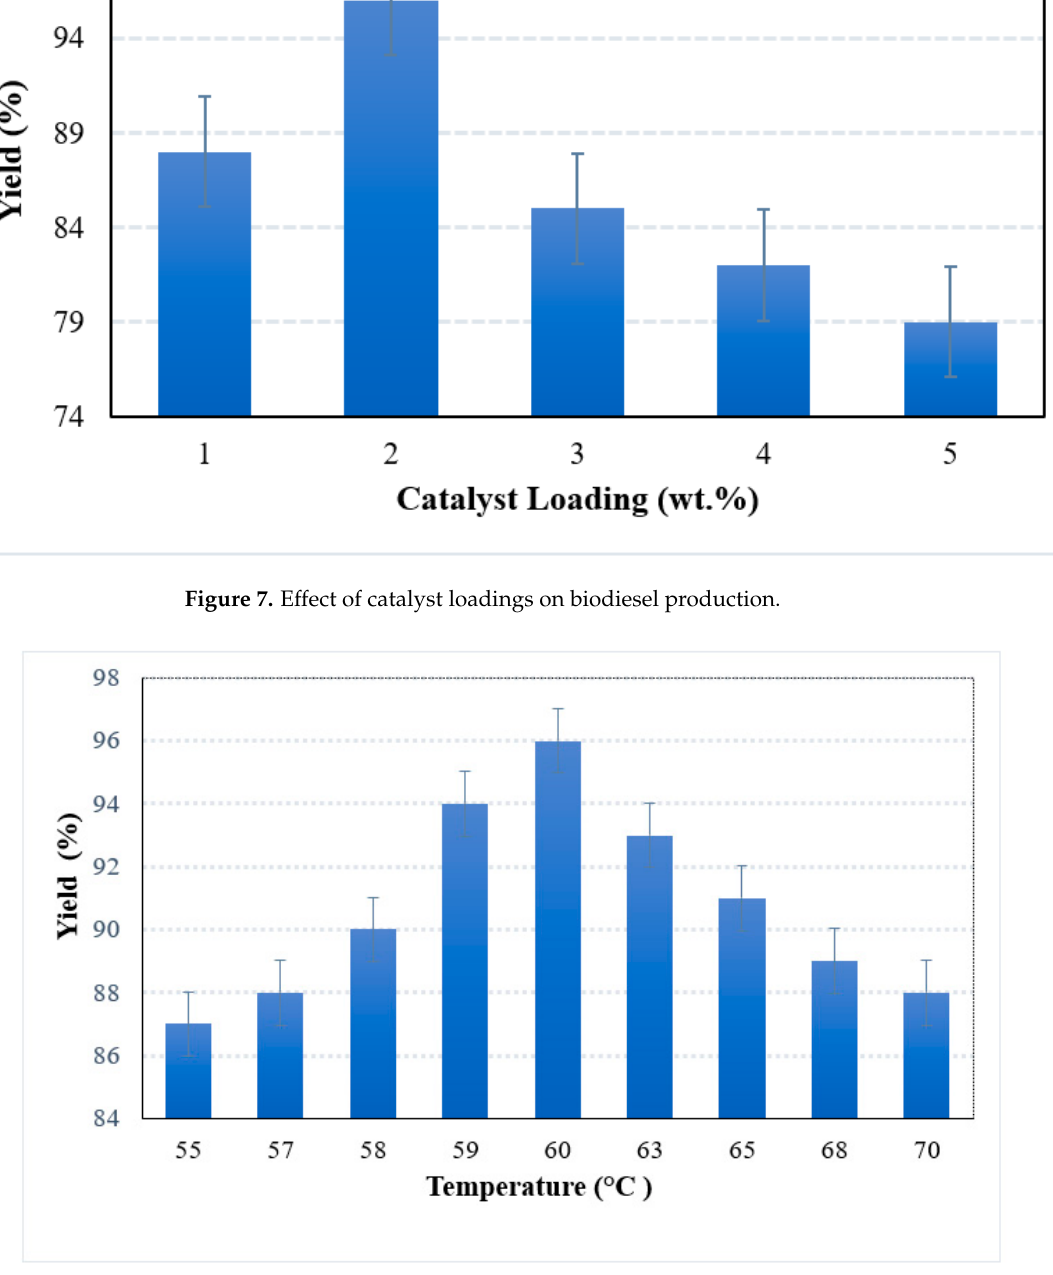
Figure 9. Effect of reaction time on biodiesel production.